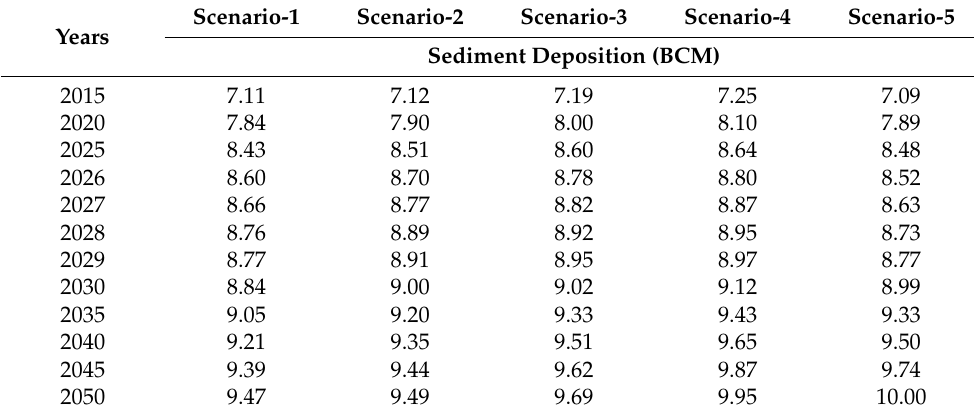
Table 2. Description of 80% deposition against operated scenarios [40,47].